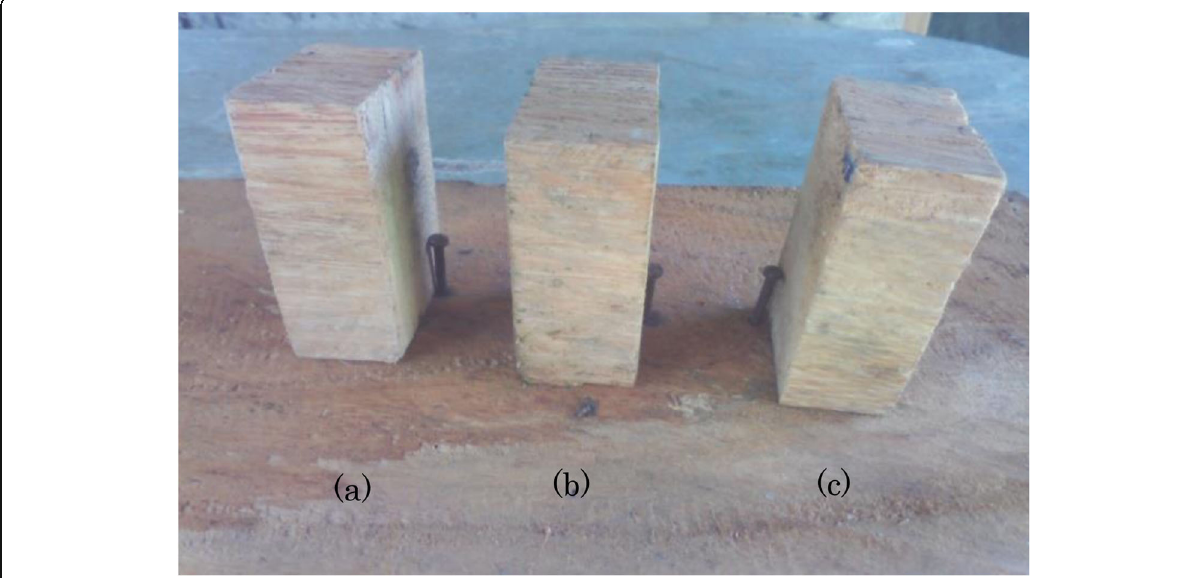
Fig. 5 Coco wood (lumber) samples and set-up with ( a ) controlled sample ( b ) sample with leaves extract and ( c ) sample with fruit